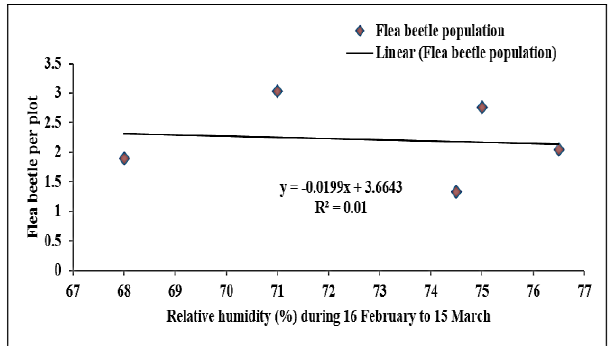
Figure 4: Relationship between the population of flea beetle and relative